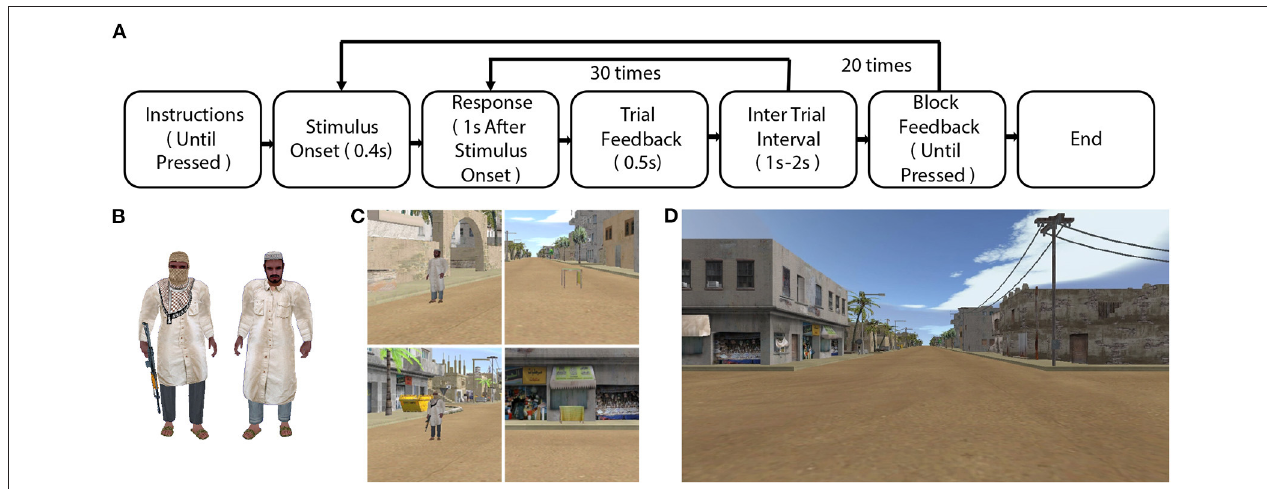
FIGURE 1 | Method. (A) A flow chart of the training experiment. (B) Stimuli used in the go/no-go training task. (C) Trained (left column) and untrained (right column) threat (top row) and non-threat (bottom row) stimuli in the transfer task. (D) A screenshot from the transfer task.